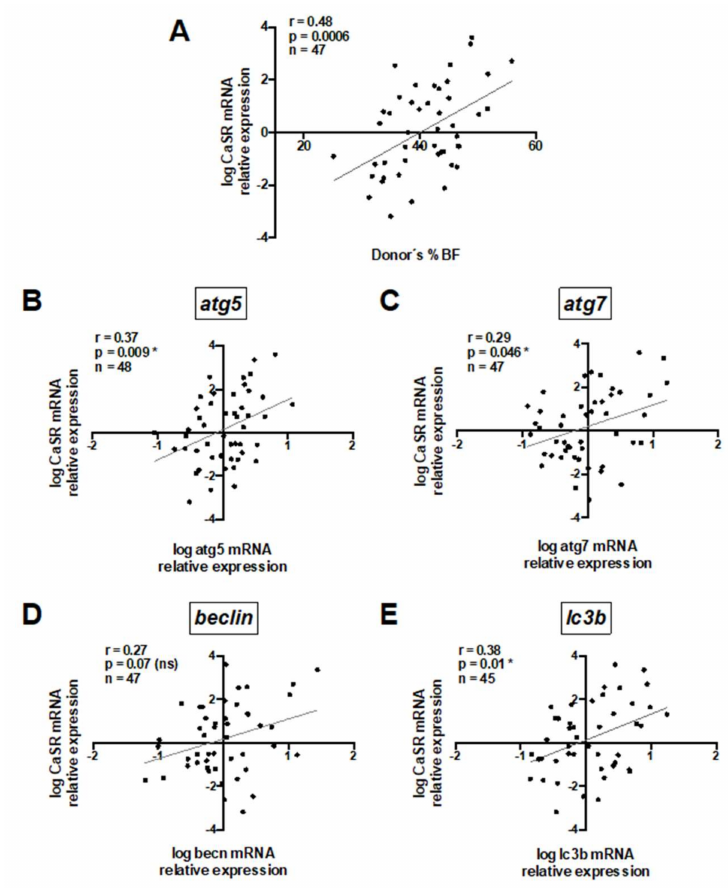
Figure 1. Whole adipose tissue calcium-sensing receptor (CaSR) mRNA content positively correlates with donors’ body fat percentage and mRNA of autophagy markers. Pearson’s correlation coe ffi cient was calculated for the association between CaSR mRNA and ( A ) body fat percentage (%BF), ( B ) atg5 , ( C ) atg7 , ( D ) becn and ( E ) lc3b . All mRNA values were log transformed. Each graph depicts the r, and p values, as well as the number of explants analyzed (1 explant = 1 donor) (n). * Significant and ns =